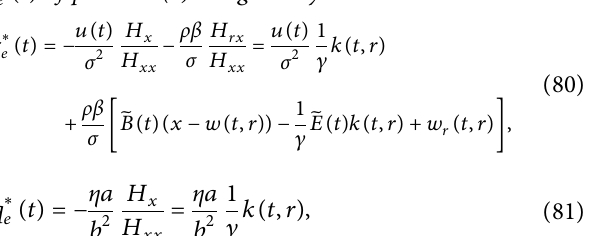
Figure 2: The effects of β on π ∗